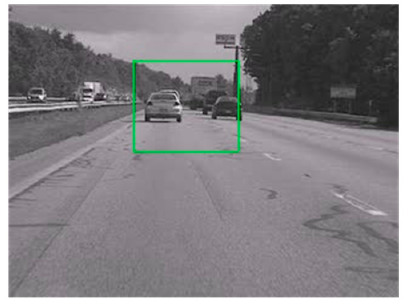
Figure 15. Region of interest indicated within the green box for an image sequence.